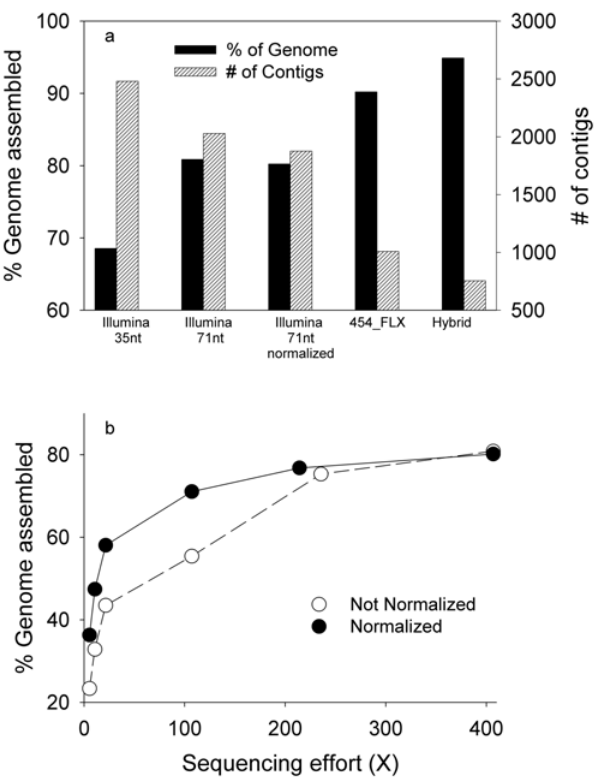
Figure 4. Comparison of denovo assembly results using 454-FLX and Illumina sequencing data. A) Fraction of genome (solid bars) and number of contigs (stripped bars) assembled de novo using various sequencing approaches. The sequencing efforts on each platform were: